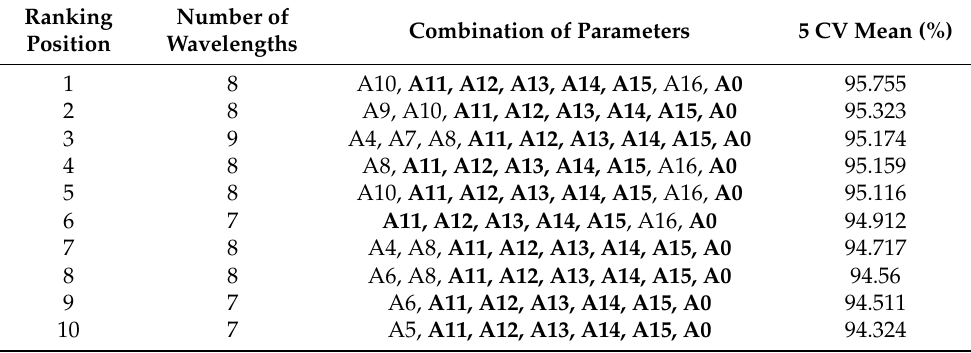
Table 9. Top 10 ranking for multiple wavelength usage for white eggshells with hyperparameter op- timization and decreased C parameter value. Parameters given in bold indicate the key wavelengths for white eggs